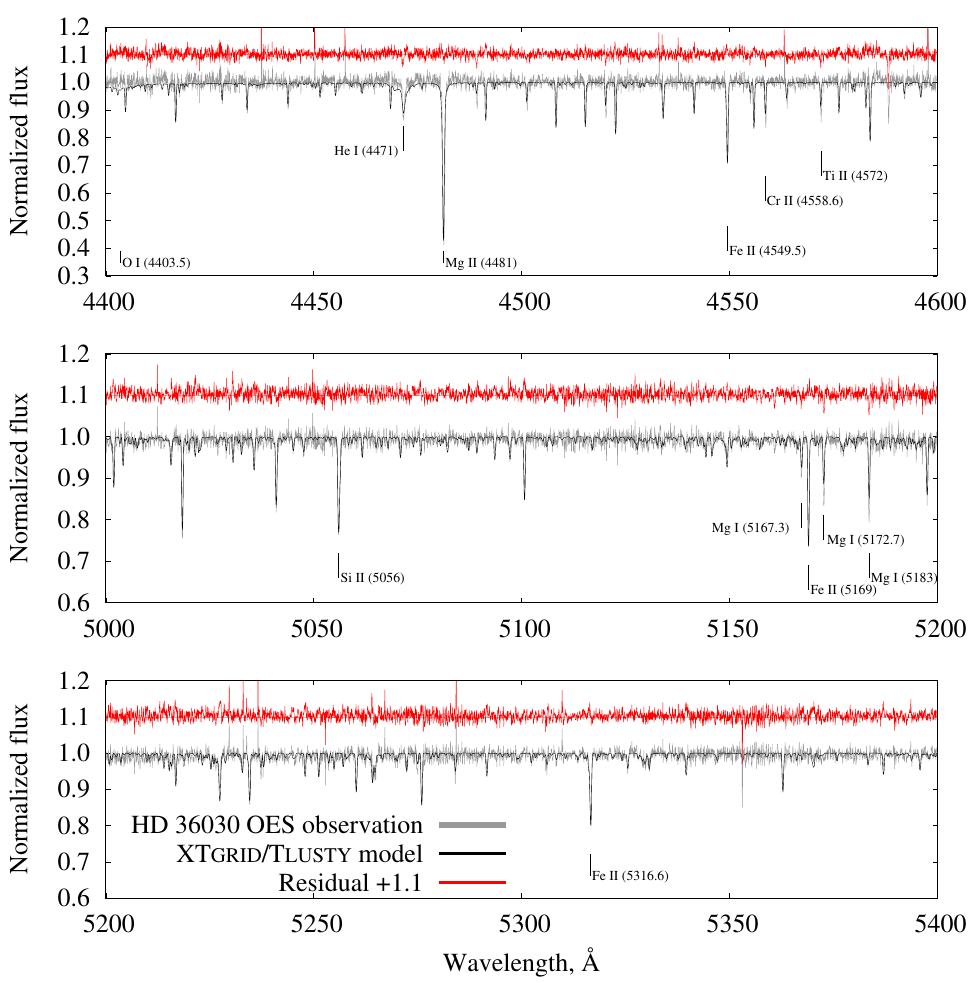
Figure 6. Selected intervals from Figure 5. Table 3. Surface parameters of HD36030 from the analysis of the OES